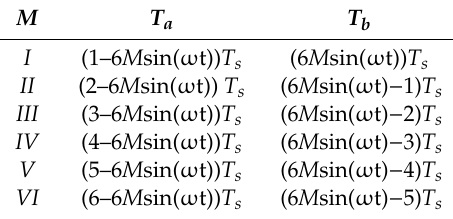
Table 4. Switch working time of a